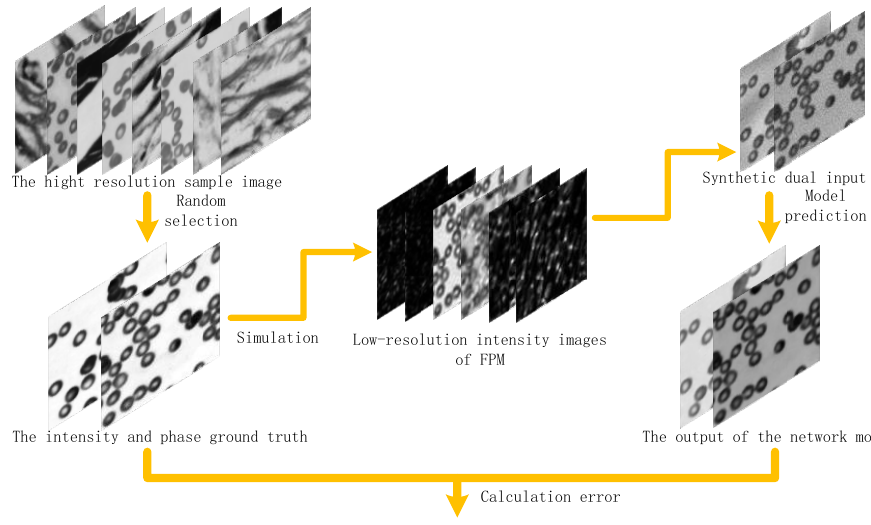
Figure 8. Construction of the dataset and training process of the network model.